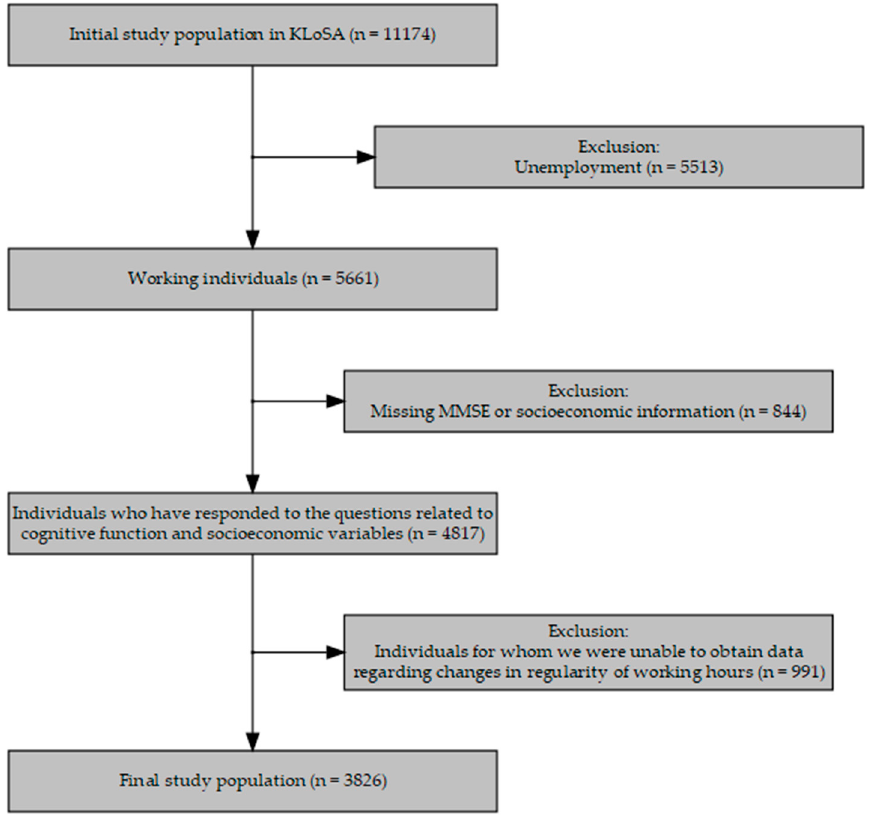
Figure 1. Flowchart showing the selection of the study participants. KLoSA, Korean Longitudinal Study of Aging; MMSE, mini–mental state examination.